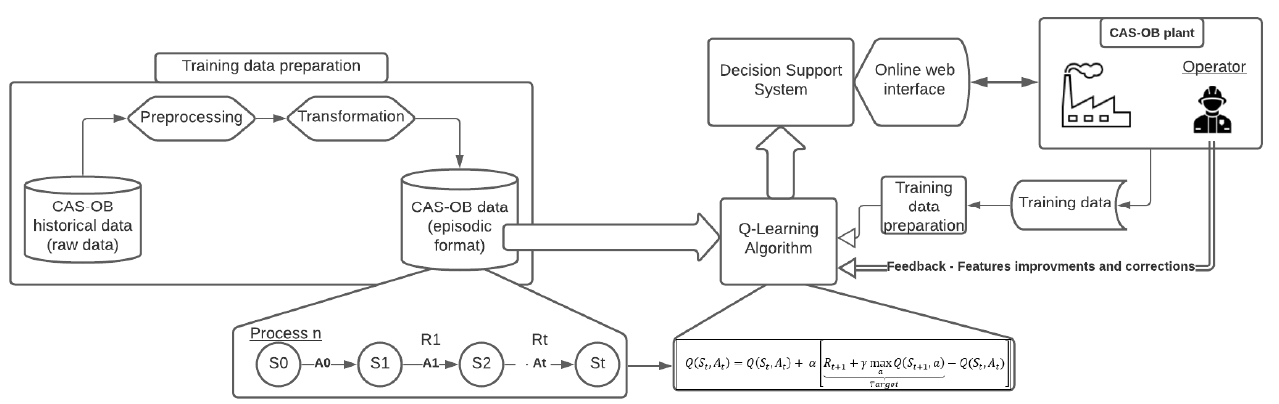
Figure 5. Scheme of solution developed and implemented.